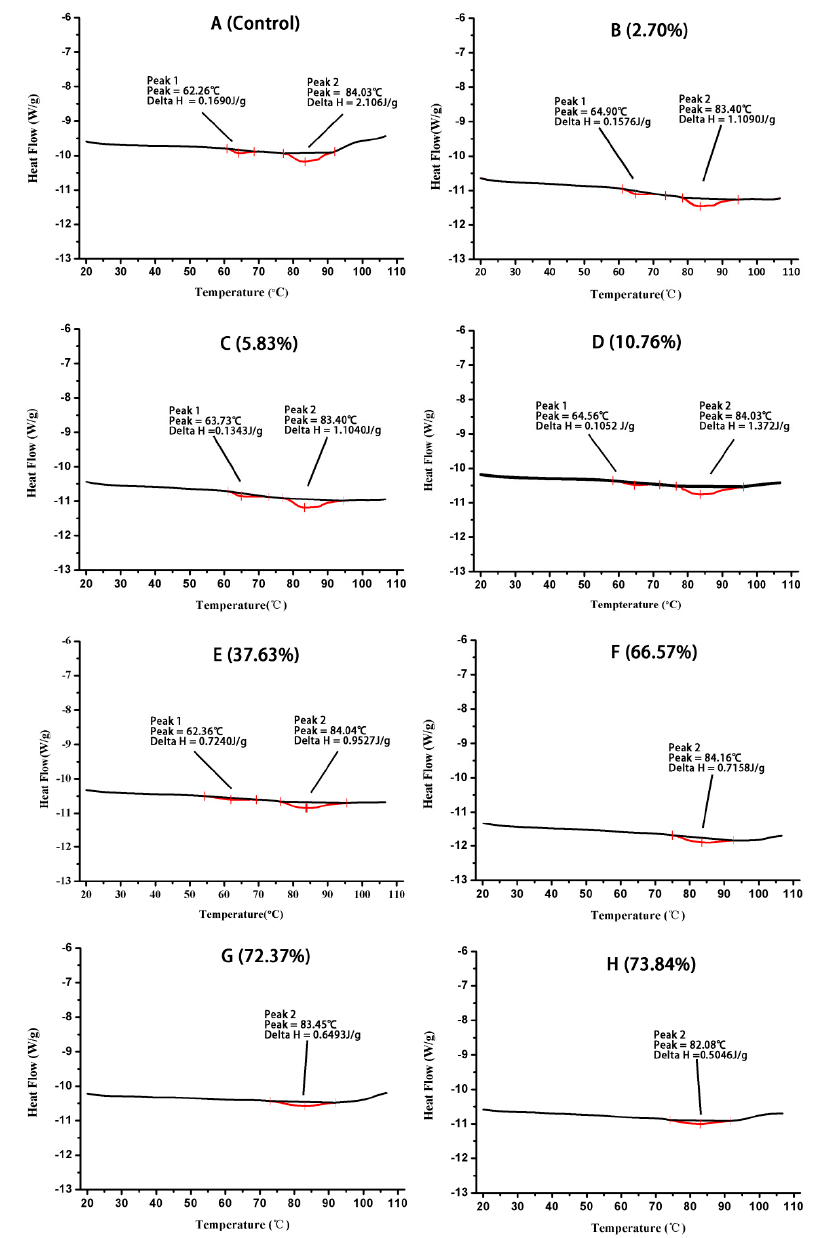
Figure 3. Differential Scanning Calorimetry (DSC) thermograms of EWP ( A —0%) and SEWP with various succinylated degrees ( B —2.70%, C —5.83%, D —10.76, E —37.63%, F –66.57%, G —72.37%, and H —73.84%).